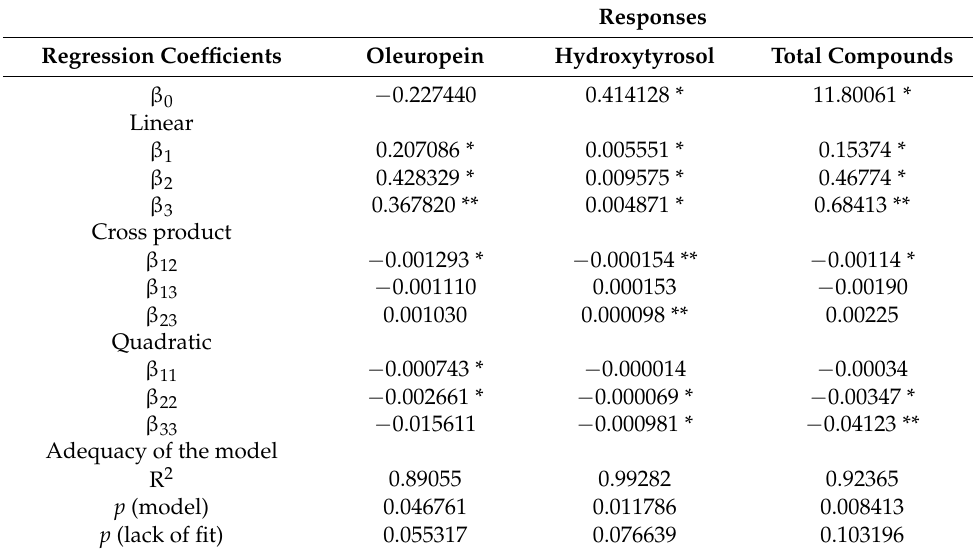
Table 2. Regression coefficients and analysis of variance (ANOVA) of the models for the variables of response of oleuropein, hydroxytyrosol and total